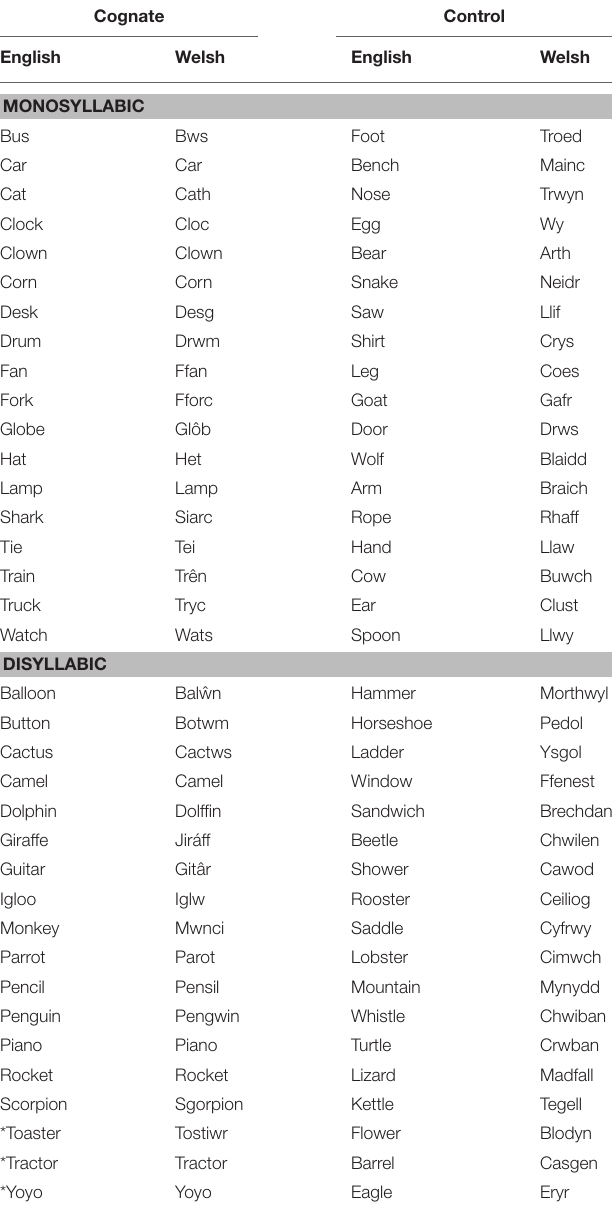
TABLE A | Experimental stimuli. Cognate Control English English